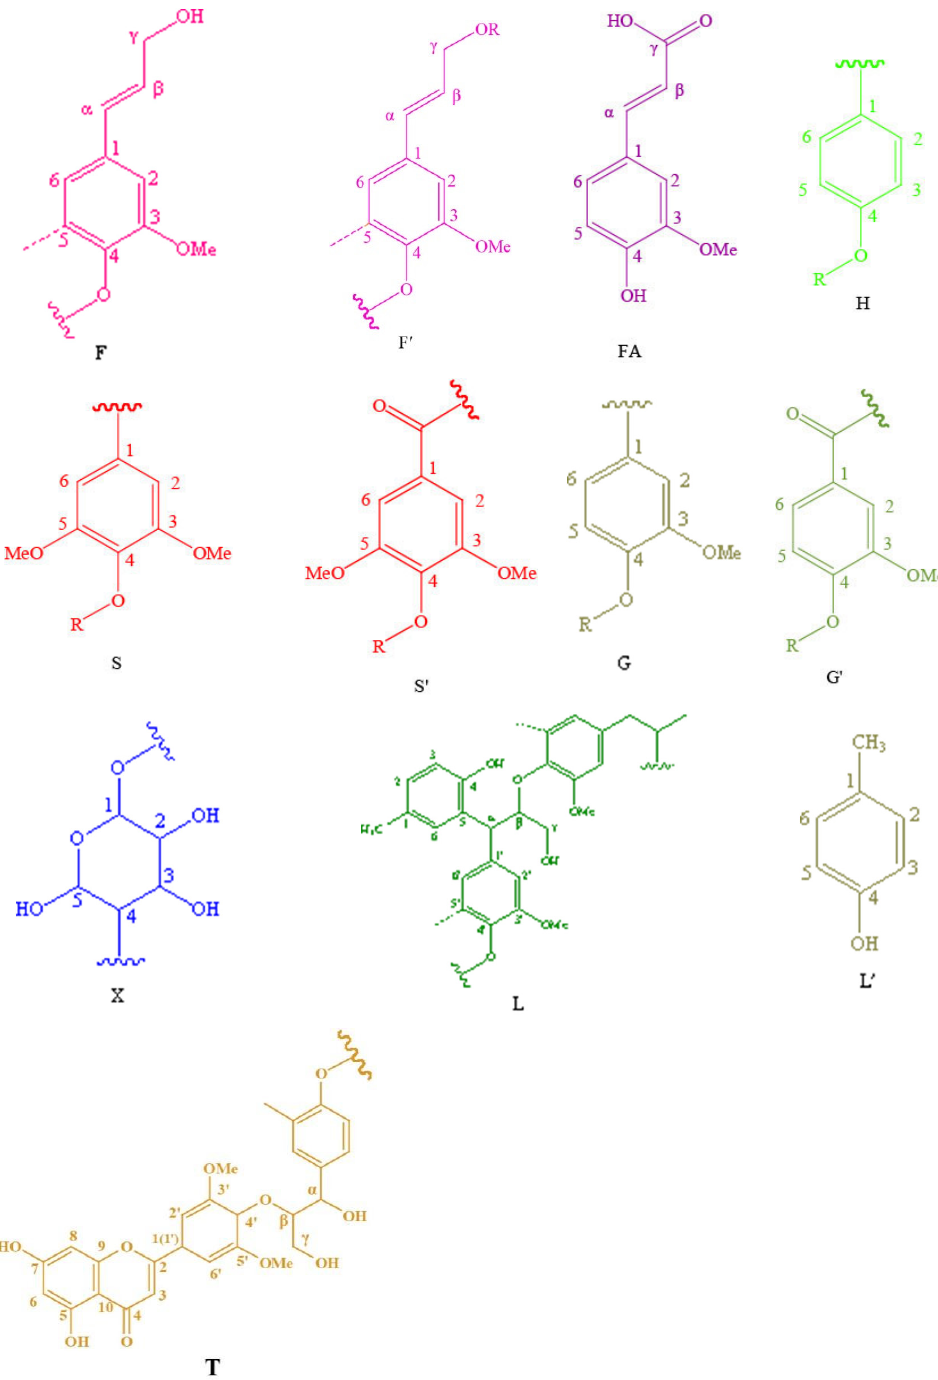
Figure 7. Main lignin unit and linkages in the lignin preparations: ( A ) β-O-4 alkyl-aryl ethers; ( A′ ) β-O-4 alkyl-aryl ethers with acylated γ-OH with pcoumaric acid; ( B ) resinol structures formed by β-β/α-O-γ/γ-O-α linkages; ( B′ ) tetrahydrofuran structures formed by β-β linkages; ( IC ) phenyl- coumarane structures formed by β-5/α-O-4 linkages; ( F ) p -hydroxycinnamyl alcohol end-groups; ( F′ ) p -hydroxycinnamyl alcohol end-groups acylated at the γ-OH; ( p CA ) p-coumarates; ( FA ) feru- lates; ( H ) phydroxyphenyl units; ( G ) guaiacyl units; ( G′ ) oxidized guaiacyl unit linked a carbonyl at Cα; ( S ) syringyl units; ( S′ ) oxidized syringyl units bearing a carbonyl at Cα; ( X ) xylopyranoside; ( L ) lignocresol; ( L′ ) p -cresol; ( T ) tricin.